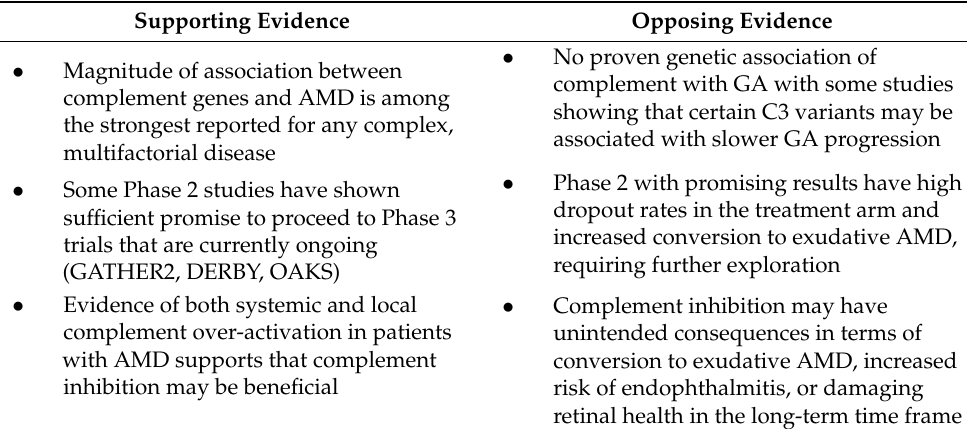
Table 3. Evidence for and against complement inhibition as a viable strategy for slowing geo- graphic